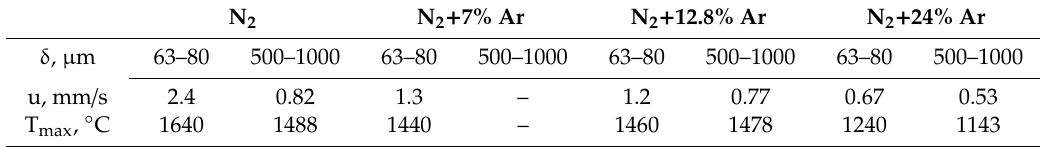
Table 2. Maximum temperature and burning rate of chromium, depending on the content of argon.